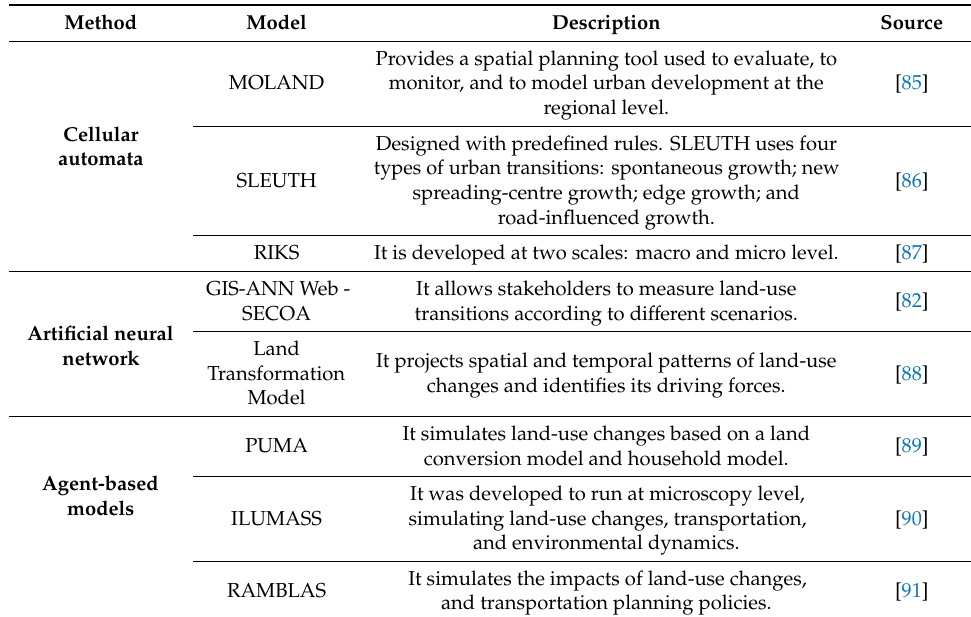
Table 2. Land-use models based on CA, ANN, and